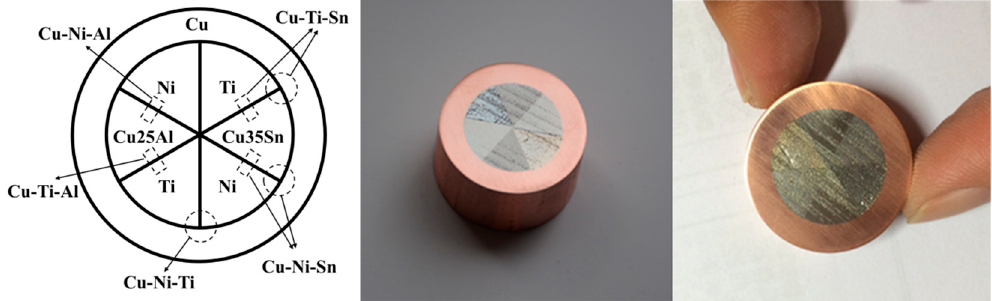
Figure 1. Cross section of Cu–Ni–Ti–Cu20Al–Cu35Sn diffusion multiple.